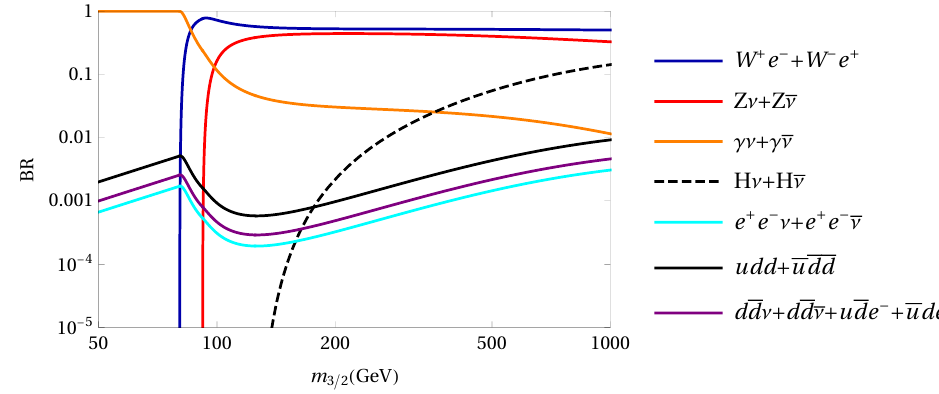
Figure 1 . The decay branching ratios of the ψ of m for Λ = 1 TeV and c q = c l = c lq = c B = c W = c φ = 1 3 / 2